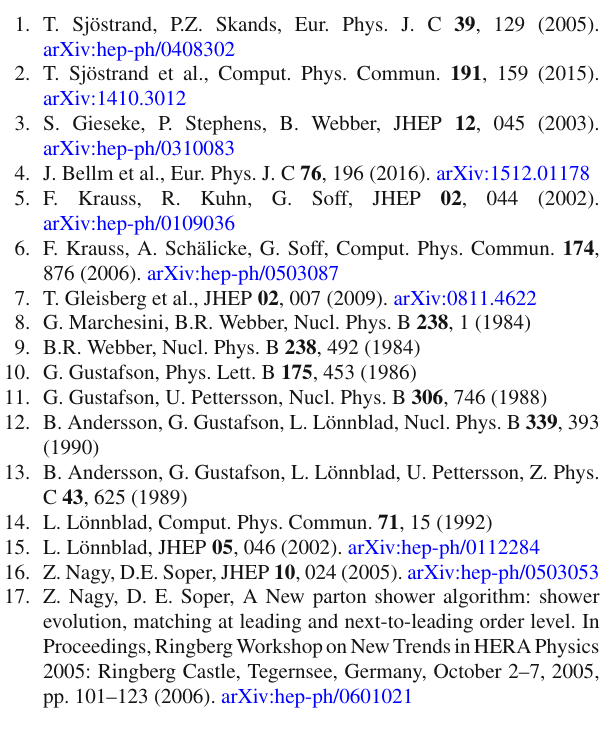
Fig. 5 Position of the peak of the thrust distribution as a function of the shower cutoff Q 0 for e + e − → ¯ tt . The centre-of-mass energy is Q = 1000GeV. Displayed are the plots for (cid:3) m , 0 = 1GeV (left) and